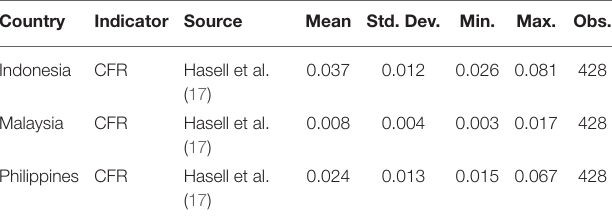
TABLE 1 | Descriptive statistics.